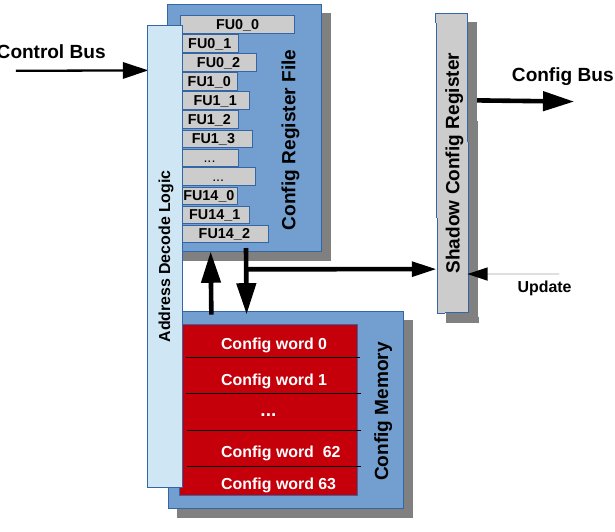
Figure 7. Configuration